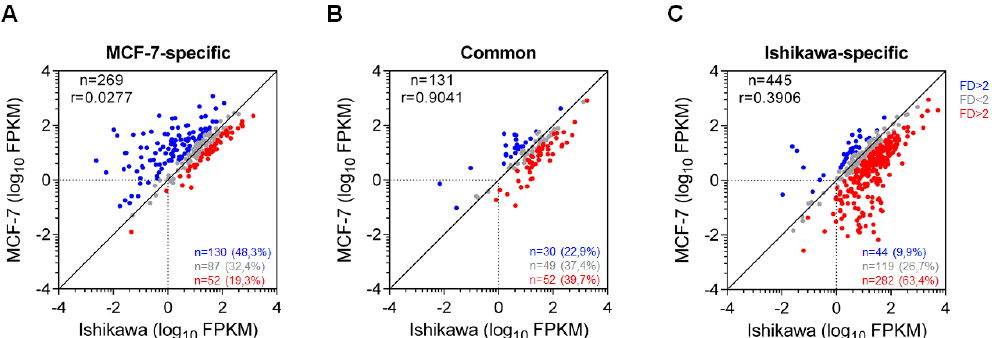
( B ) and Ishikawa-specific ( C ) ER α -driven SEs. Grey dots represent genes within a 2-fold di ff erence (FD) range between both replicates of MCF-7 and Ishikawa cells; blue and red dots represent genes that exceed this range and are specific to MCF-7 or Ishikawa cells, respectively. The plots contain the number of the genes represented by blue, red or grey dots and the percentage values relative to the total gene